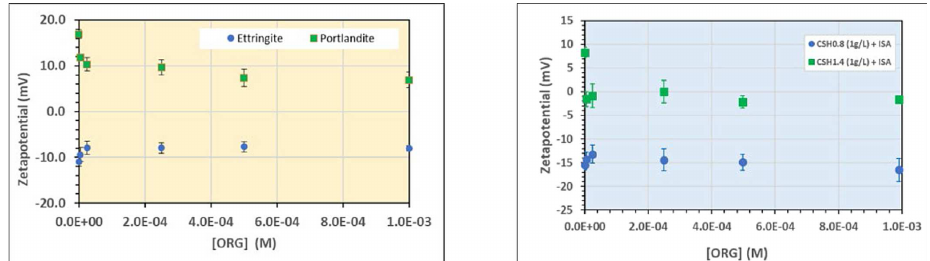
Fig. 7. Zeta potential measurements as a function of ISA concentration ([ORG]) on portlandite and ettringite (left) and C–S–H (C/S = 0.8 and 1.4) (right). (courtesy of Missana et al. [CIEMAT]).